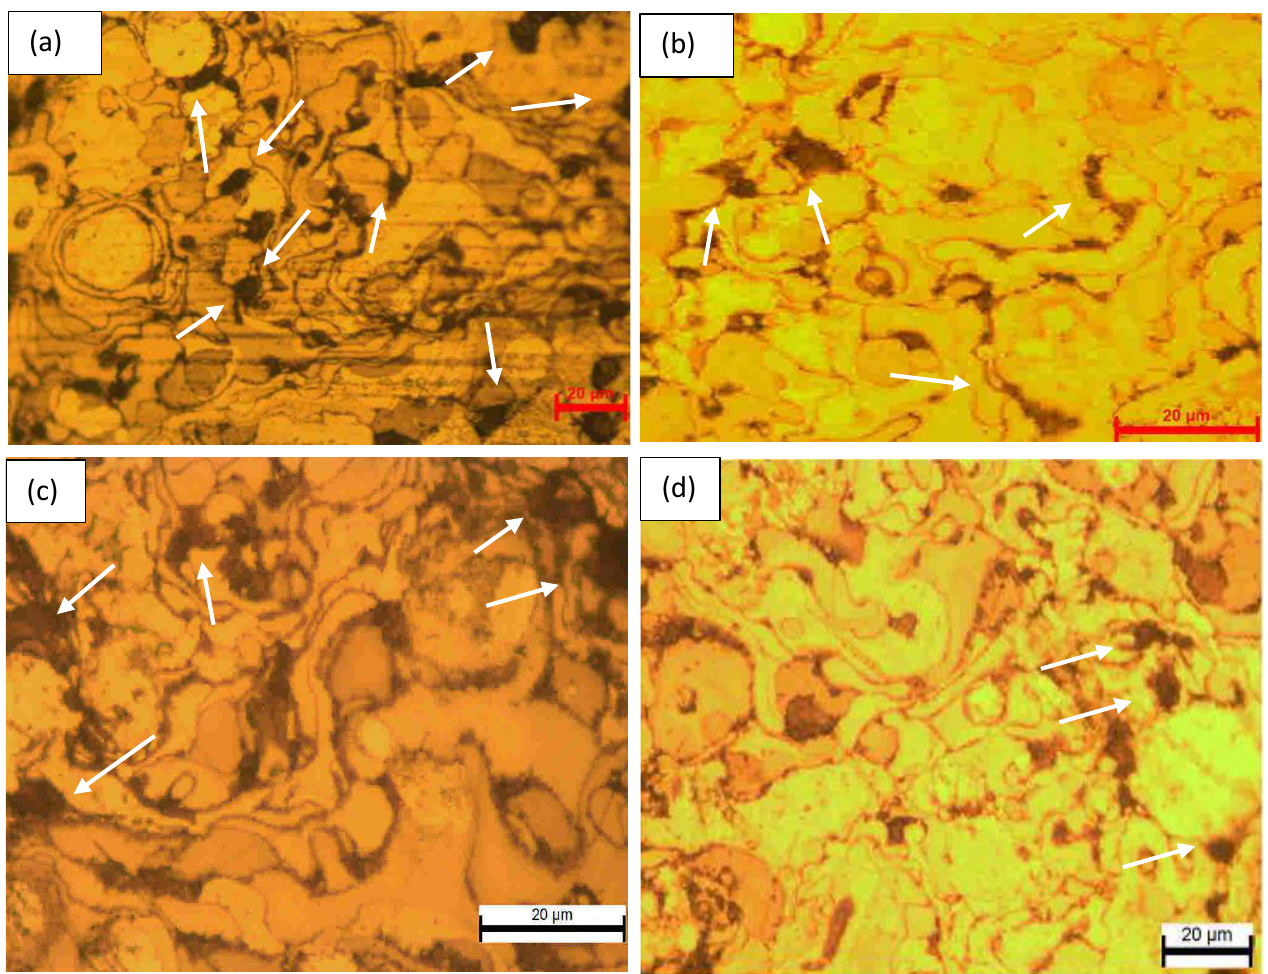
Figure 7. OM of the sample: ( a ) S7, ( b ) S8, ( c ) S9 and ( d ) optimum set.